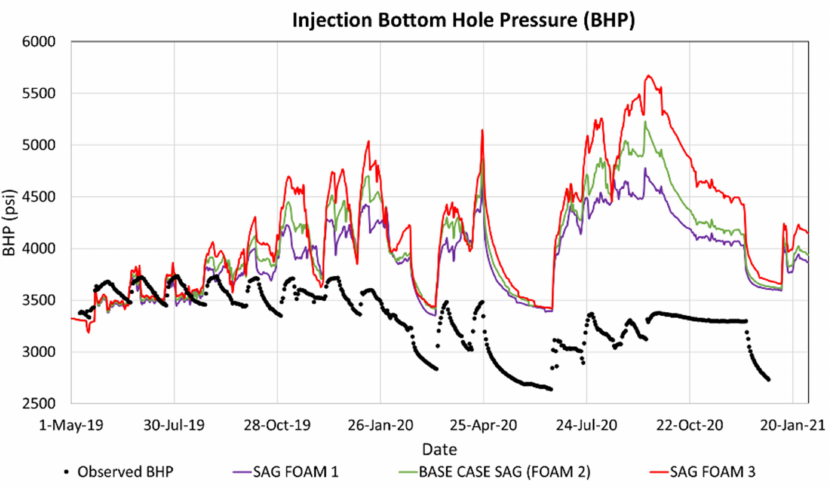
Figure 10. Injection bottom hole pressure (BHP) through time for the foam model sensitivity study. The red curve used foam model 1, the green curve is the base case SAG with foam model 2, and the purple curve used foam model 3. The observed BHP is shown as the black